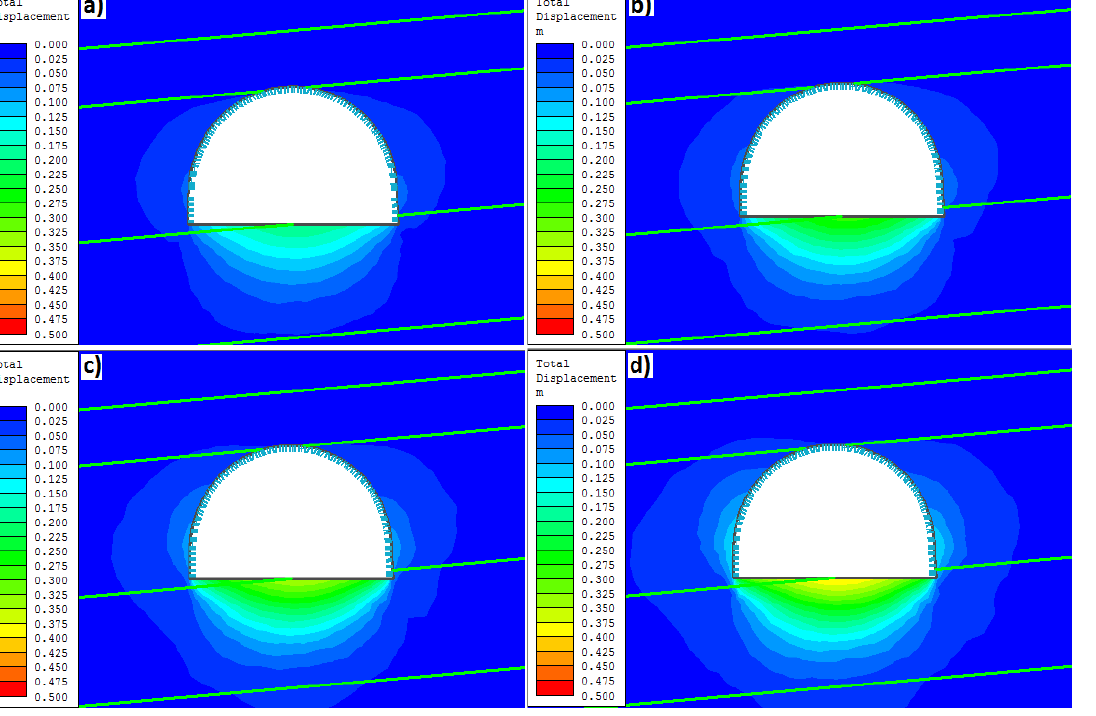
Figure 9. Charts of rock mass deformation around roadway D-2—chainage 595 m. ( a ) Deformation corresponding to measurements 180 days after roadway excavation. ( b ) Deformation corresponding to measurements after 366 days after roadway excavation. ( c ) Deformation corresponding to mea- surements after 573 days after roadway excavation. ( d ) Deformation corresponding to measurements after 724 days after roadway